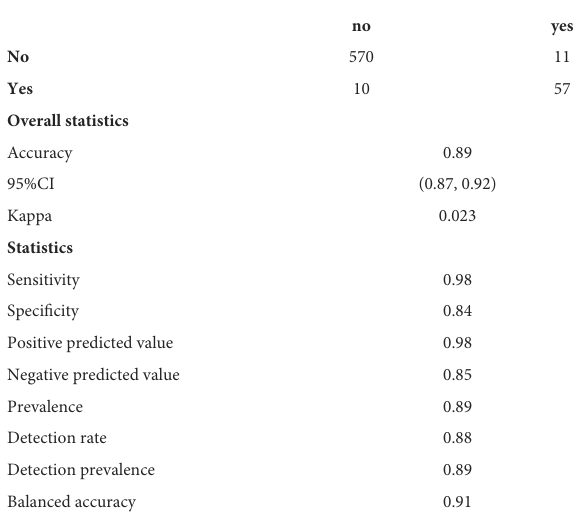
TABLE 4 Confusion matrix of XGBoost